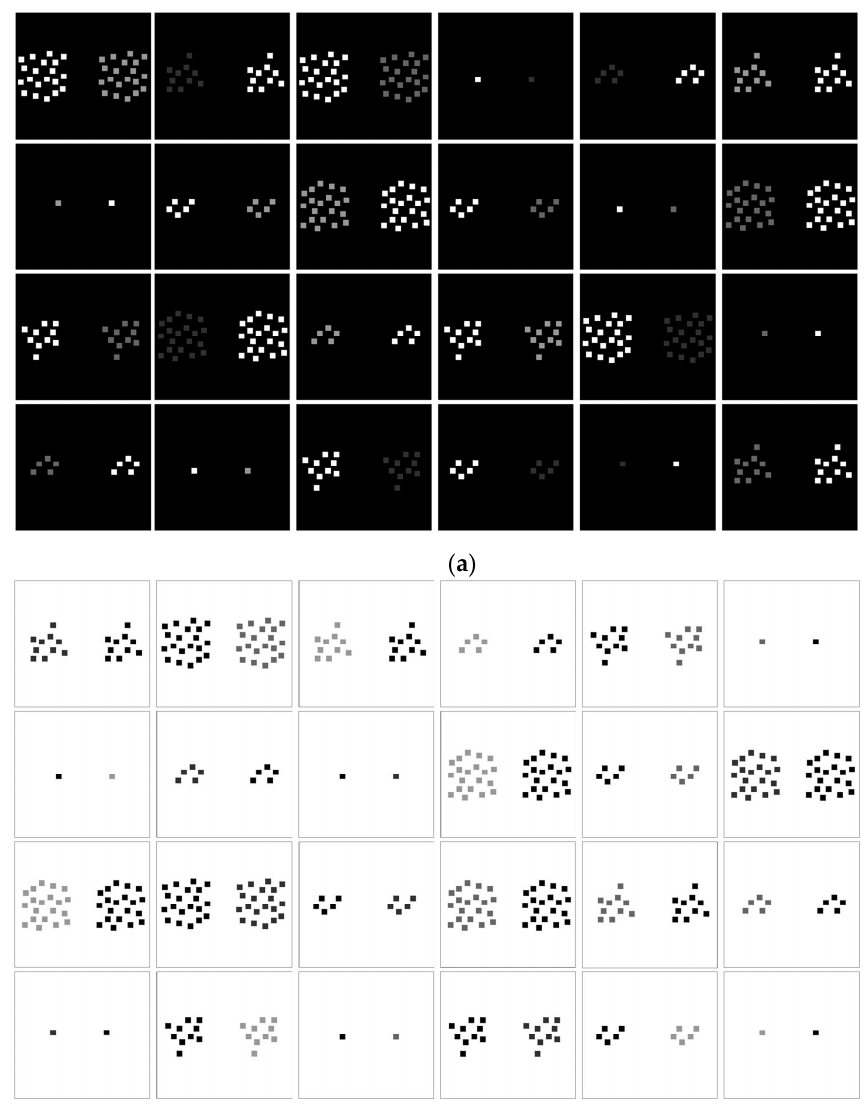
Figure 1. Forty-eight paired image configurations with variable contrast intensities used as stimuli in the experiments. Twenty-four pairs had positive ( a ) and 24 pairs had negative ( b ) contrast polarity. Each pair was preceded by a 70 dB pure tone sound signal (200, 1000, or 2000 Hz) in test conditions with sound.